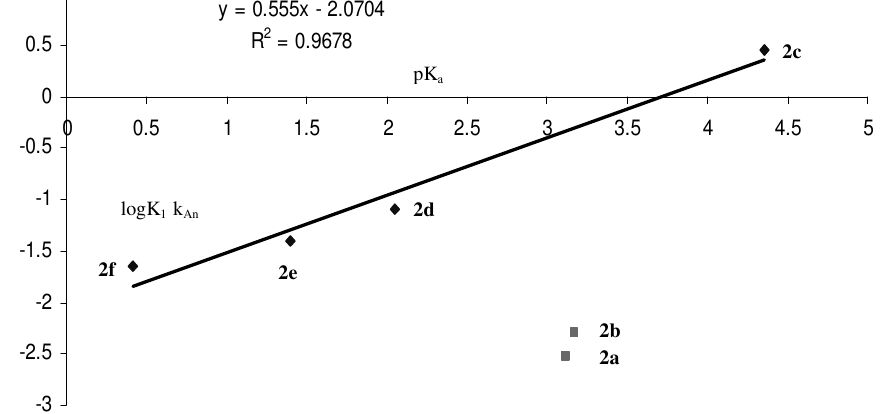
values of the a